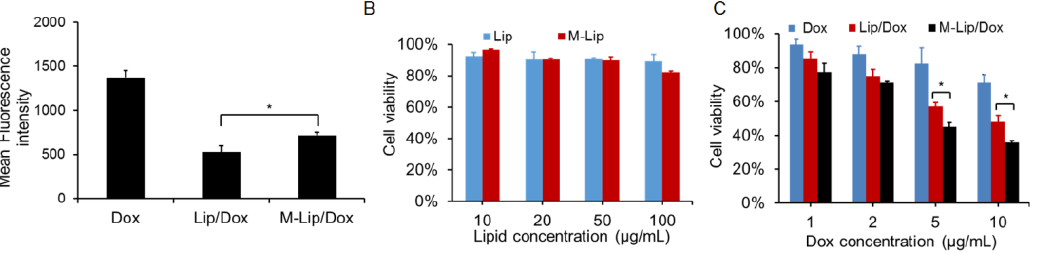
Figure 2. Cellular uptake and cytotoxicity of liposomes. ( A ) Uptake of different formulations into 4T1 cells (n = 3), as determined by flow cytometry. ( B ) 4T1 cell viability after incubation with blank Lip or M-Lip at 37 ° C for 24 h (n = 5). ( C ) 4T1 cell viability after incubation with different formulations at 37 ° C for 24 h (n = 5). Data are shown as mean ± SD. * p < 0.01. Dox, doxorubicin; Lip/Dox, Dox-loaded liposomes; M-Lip/Dox, maleimide-functionalized Dox-loaded liposomes. Dox is a low-molecular-weight compound that can enter nuclei and bind to DNA to induce apoptosis [28]. Therefore, the drug delivery efficacy of the prepared liposomes was assessed in terms of Dox-induced cytotoxicity [29]. We found that blank Lip and blank M-Lip were non-toxic at low concentrations (Figure 2B). However, M-Lip/Dox effectively inhibited cell growth in a dose-dependent manner, showing a stronger inhibitory effect than Lip/Dox (Figure 2C). This suggests that maleimide functionalization can improve the uptake of liposomes into cells and enhance the antitumor efficacy of Dox.